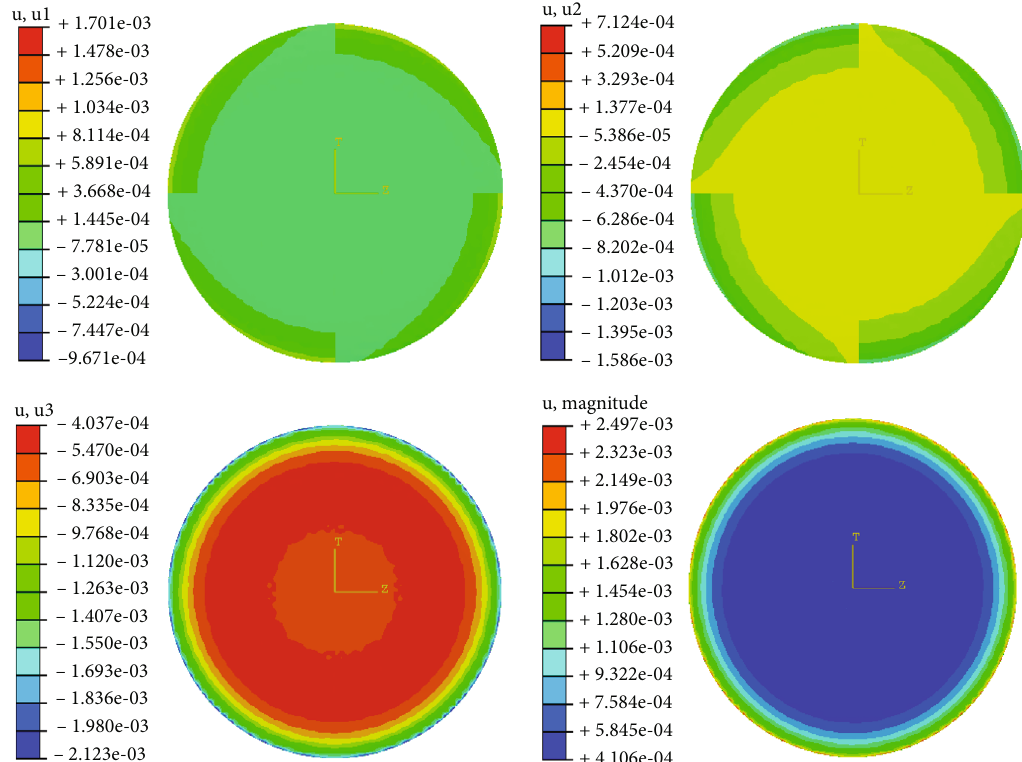
Figure 14: Displacement cloud images of proppant